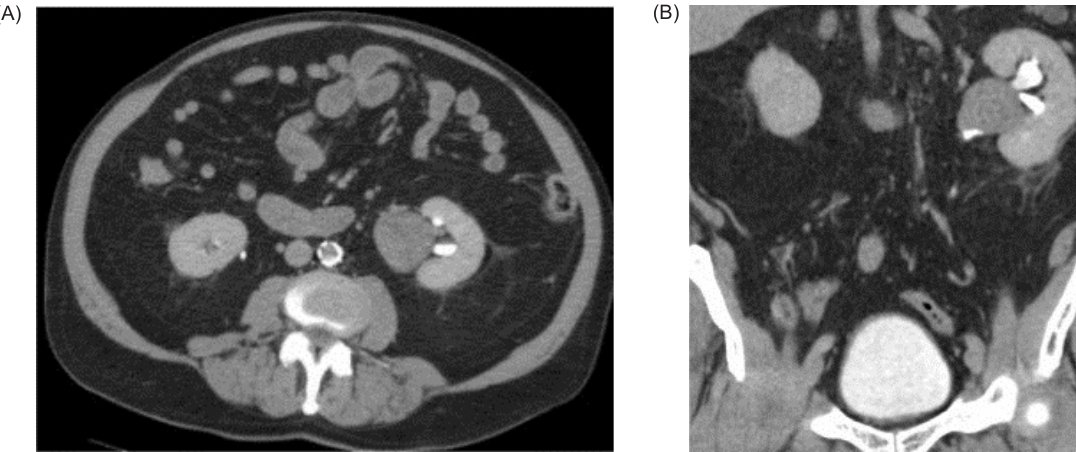
Figure 1: Left renal pelvis mass on delayed phase of CT Urogram. (A) Axial (B)